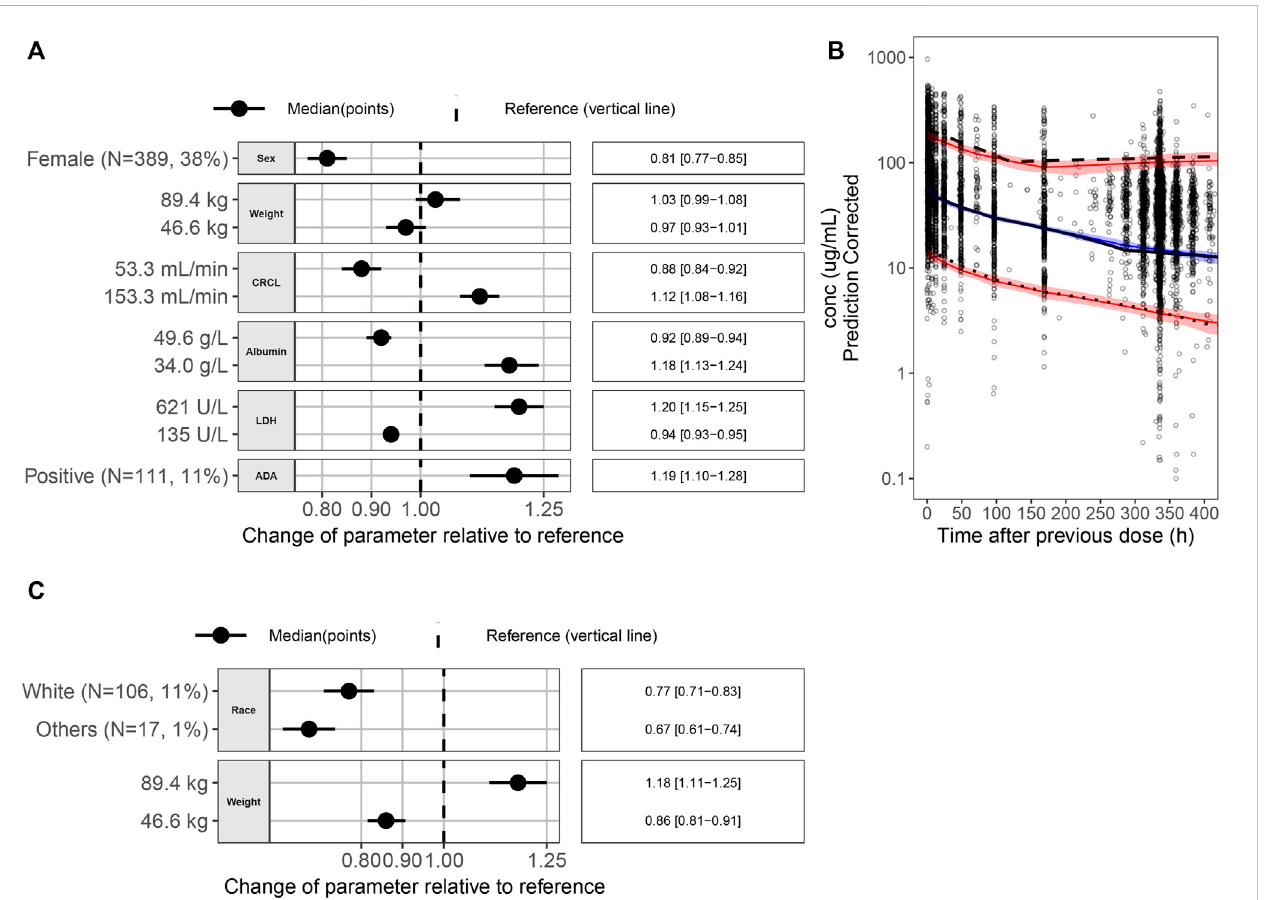
FIGURE 1 (A) CovariateeffectsonCL. (B) pcVPCforthe fi nalPopPKmodel.Blackdotsaretheobserveddatapoints.Theblacksolidlineistheobservedmedian;the black dashed line is the observed p95; and the black dotted line is the observed p5. The blue solid line is the simulated median, and the red solid lines are simulatedp5andp95.Theblueareaisthe95%PIofthesimulatedmedian,andthepinkareasarethe95%PIofthesimulatedp5andp95. (C) Covariateeffects on V 1 . Abbreviations: p5 = 5th percentile; p95 = 95th percentile; pcVPC = prediction-corrected visual predictive check; PI = prediction interval; PK = pharmacokinetic; ADA = antidrug antibody; CI = con fi dence interval; CL = clearance; CRCL = creatinine clearance; LDH = lactate dehydrogenase; N = number of patients; V 1 = volume of distribution.